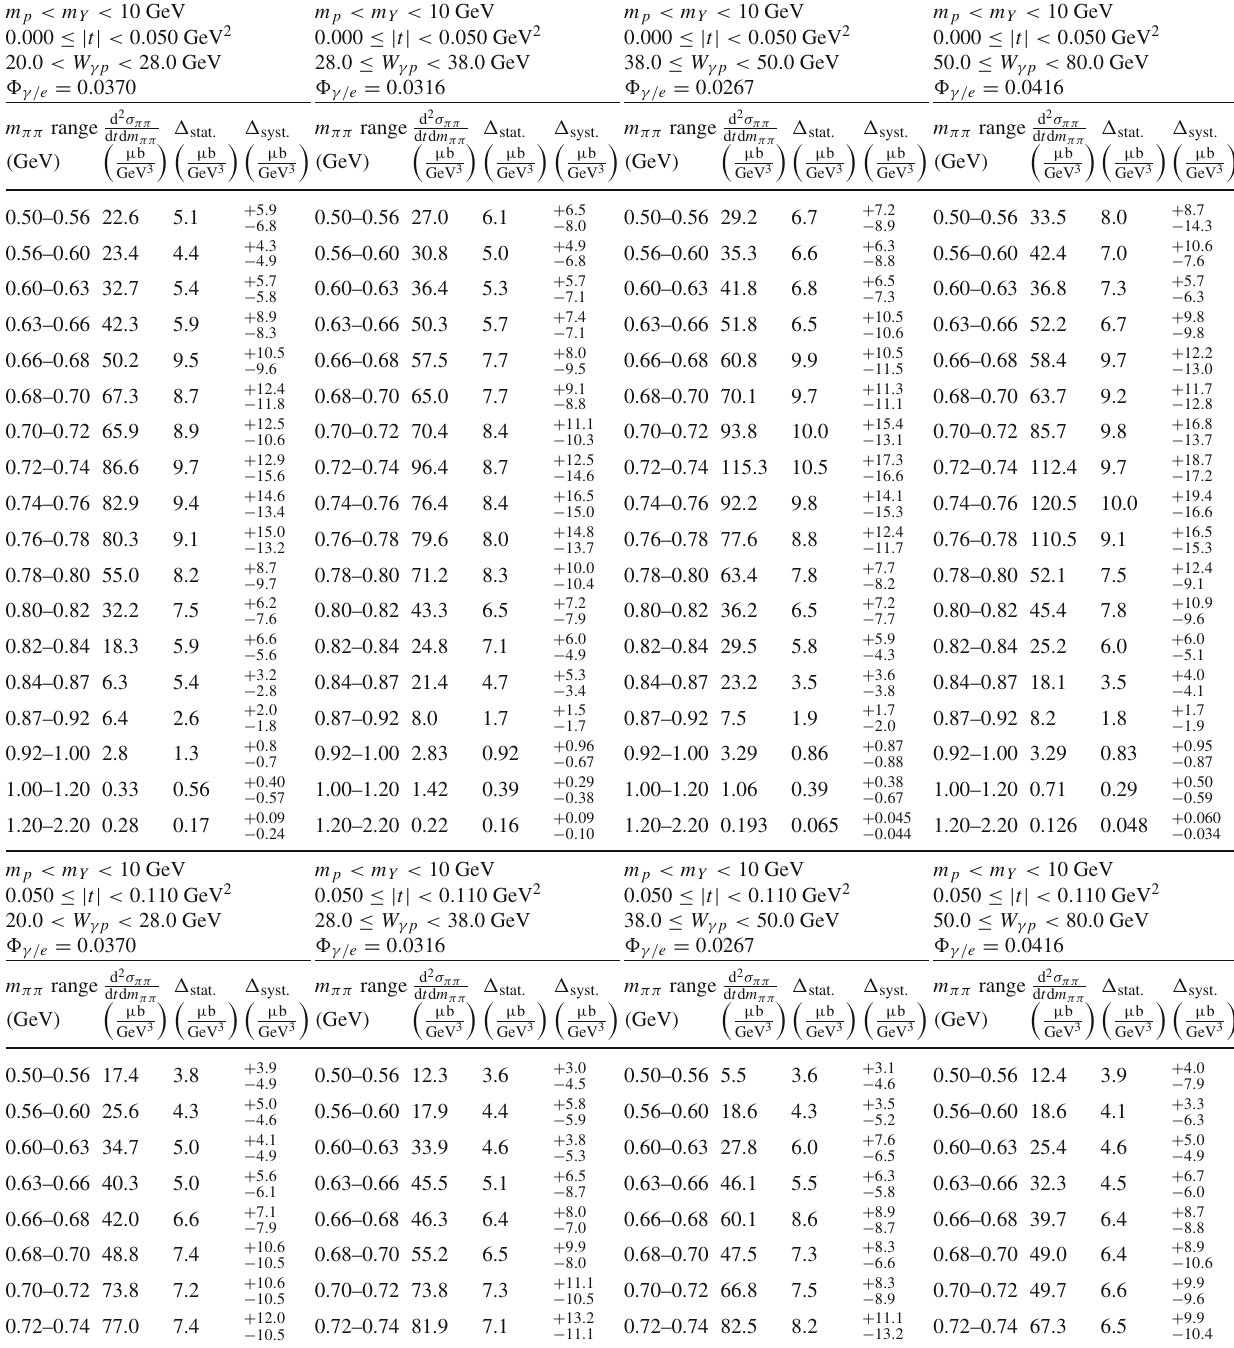
(cid:14) γ/ Table 23 Unfolded proton-dissociative e for each W γ p bin are given. The statistical and full systematic uncertainties including normalisation uncertainties are given by (cid:20) stat. photoproduction and (cid:20) syst. , respectively. A full uncertainty breakdown and statistical section is measured in the fiducial phasespace defined in Table 3 and correlations are provided [77]. The data are shown Fig. calculated according to Eq. (28). The effective photon flux factors